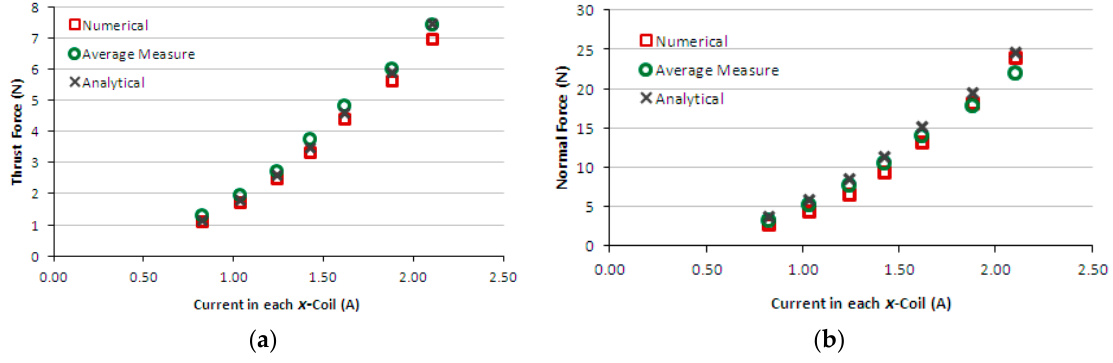
Figure 9. Case 1: ( a ) thrust force and ( b ) normal force produced by the induction planar actuator with only the x -winding excited. Sensors 2016 , 16 , 407